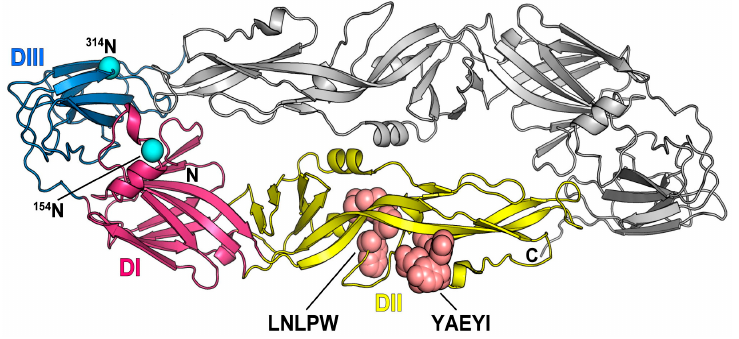
Figure 7. The locations of epitopes on the DTMUV E protein dimer. The DTMUV E protein structure is modeled based on the JEV E crystal structure protein using MODELLER [34]. Domains I, II and III in are colored in magenta, yellow and blue, respectively, in one monomer. The other monomer is colored grey. The locations of the two epitopes are depicted as spheres and labeled. The locations of two epitopes are depicted as spheres and labeled. Two predicted N -glycosylation sites by GlycoEP [32] and NGlycPred [33] are colored as cyan.